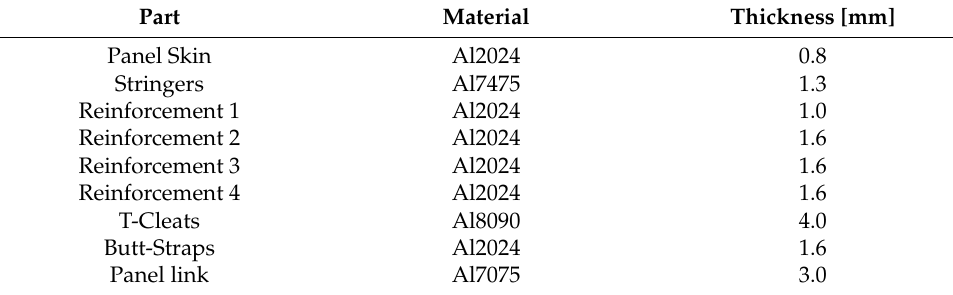
Figure 5. Aeronautical structure with OBR optical fiber (in red) and indications of the main parts. Table 1. Material and thickness of the structure’s elements.